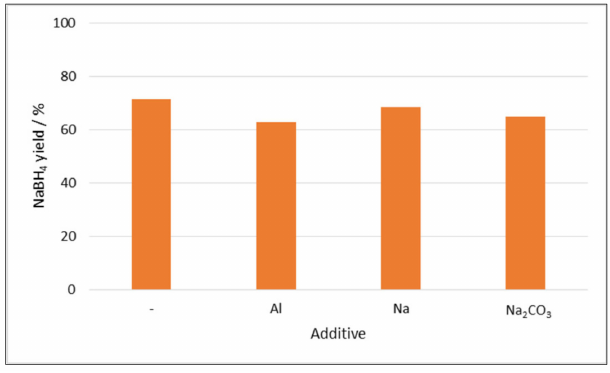
Figure 9. Effect of additive on the NaBH 4 yield. Adapted from [68].